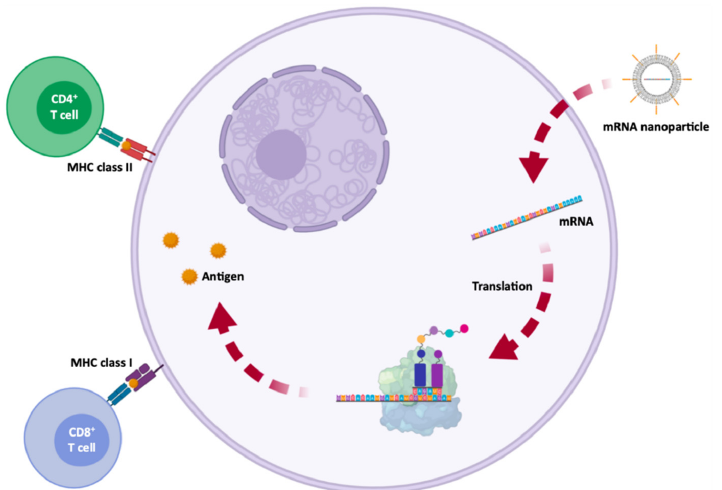
Figure 5. Antigen processing and presentation by dendritic cells, for adaptive immune system acti- vation, following subcutaneous injection of a mRNA vaccine. A synthetic mRNA is internalized by antigen presenting dendritic cells, where the mRNA is translated. Then, the antigen is exposed by class I or II major histocompatibility complex (MHC) molecules and is later recognized by CD8 + or CD4 + T cells, activating chemical and humoral responses.